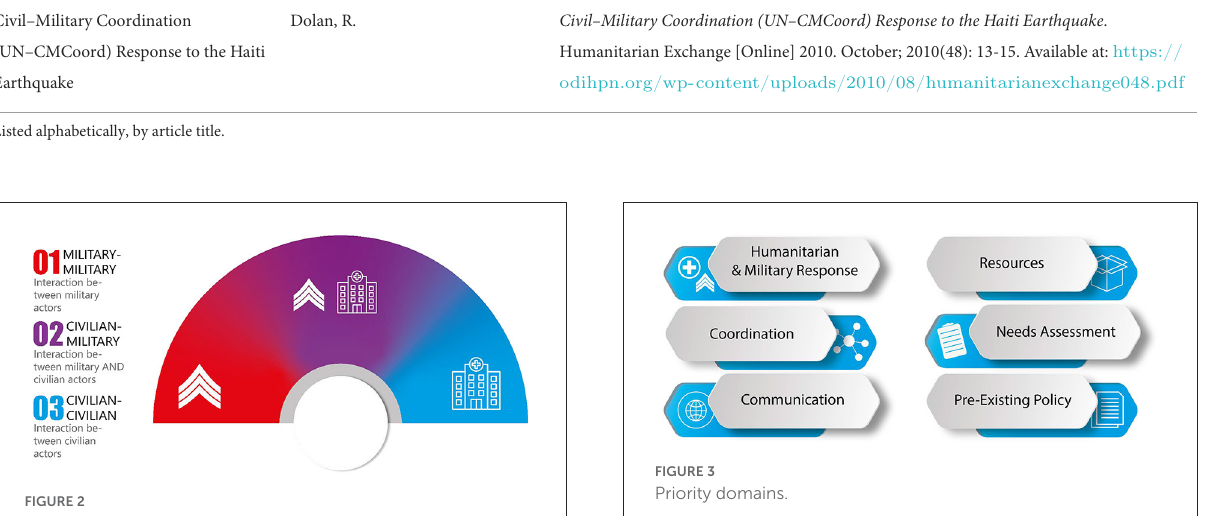
FIGURE2 Sector interaction.